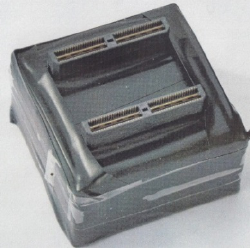
Figure 1: Neutron detection probe assembled in a rugged configuration